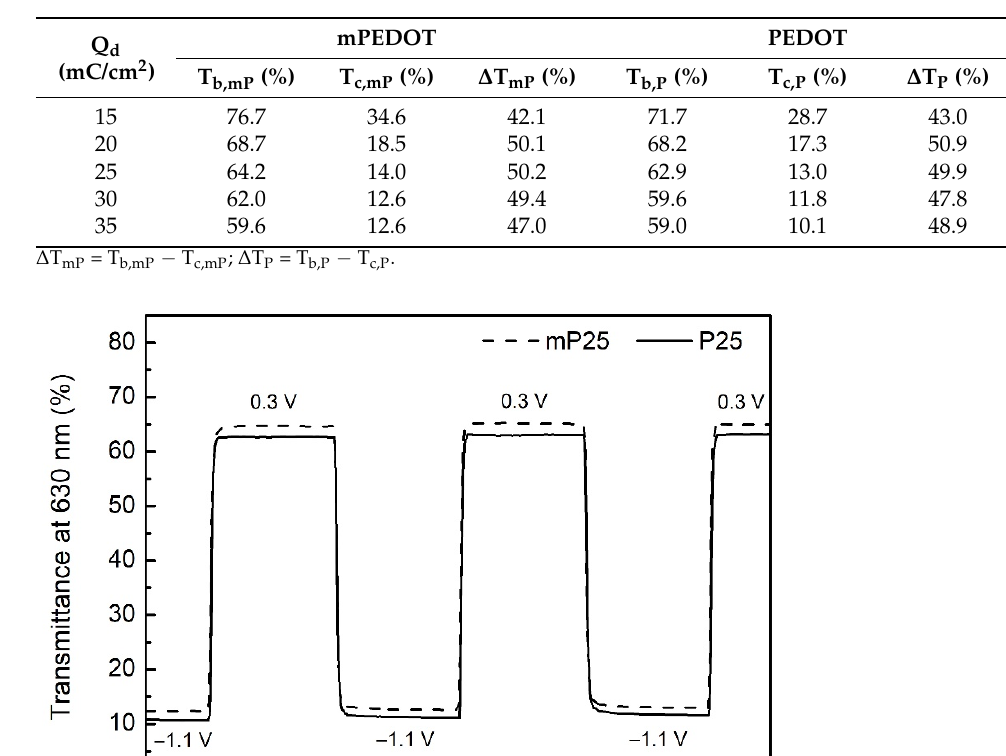
Table 4. Coloring and bleaching response times of the mPEDOT and PEDOT thin films electrode- posited with different Q d ’s. Table 3. Colored-state and bleached-state transmittance and transmittance modulation ability of the mPEDOT and PEDOT thin films electrodeposited using different Q d .